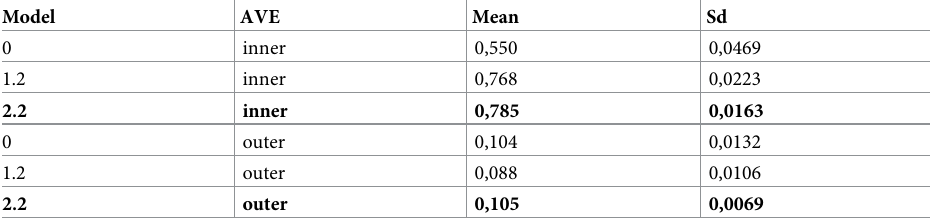
Table 2. Bootstrapped mean and standard deviation of inner and outer AVE values on the HSCT CD dataset.